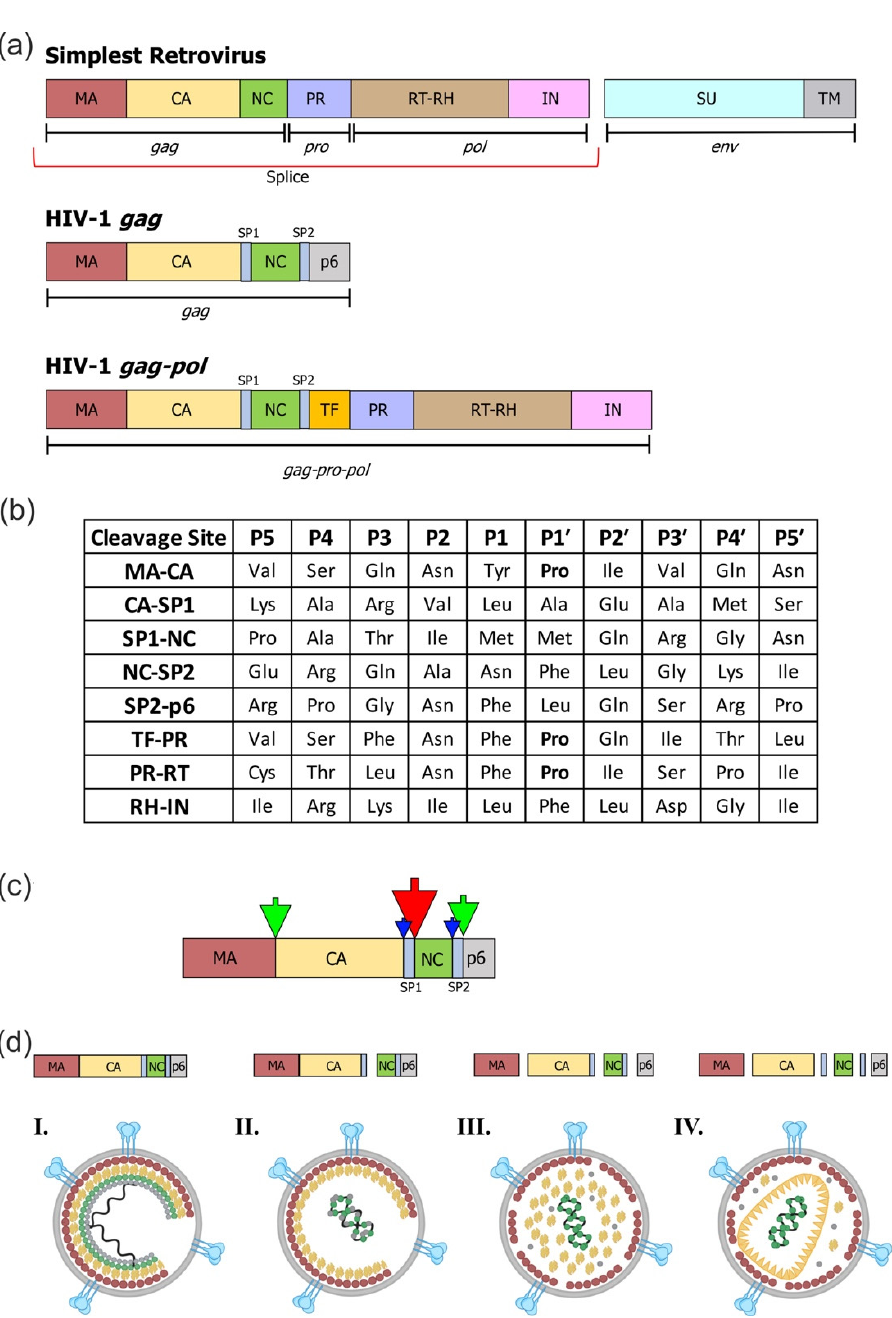
Figure 1. The Gag Polyprotein Precursor, Its Protease Cleavage Sites, and Proteolytic Processing During Virion Maturation. ( a ) The simplest organization of the retroviral Gag, Pro, and Pol coding domains consisting of MA (matrix), CA (capsid), NC (nucleocapsid), PR (protease), RT-RH (reverse transcriptase with its associated RNase H activity), IN (integrase), and the subunits of the Env protein SU (surface) and TM (transmembrane). The red line indicates the RNA splicing event that creates the subgenomic mRNA needed to express the env gene. The Gag protein and the gag gene have separate writing conventions to designate the protein versus the gene. The HIV-1 Gag protein has two additional spacer peptides (SP1 and SP2), as well as the “late domain” p6 polypeptide, which is involved in virion budding. The Gag-Pro-Pol precursor is formed by a frameshifting event at the NC/SP1 boundary that reads the p6 domain in an alternative reading frame (Transframe/TF), which is in frame with the pro and pol reading frames. ( b ) The major protease cleavage site sequences in the HIV-1 Gag and Gag-Pro-Pol precursors. The cleavage site sequences are written N to C, with the cleavage occurring between P1 and P1’. These cleavage site sequences are highly conserved as individual sequences even though they vary significantly between cleavage sites. The P1’ prolines are bolded. ( c ) The cleavage sites in HIV-1 Gag are shown, with the large red arrow indicating the first